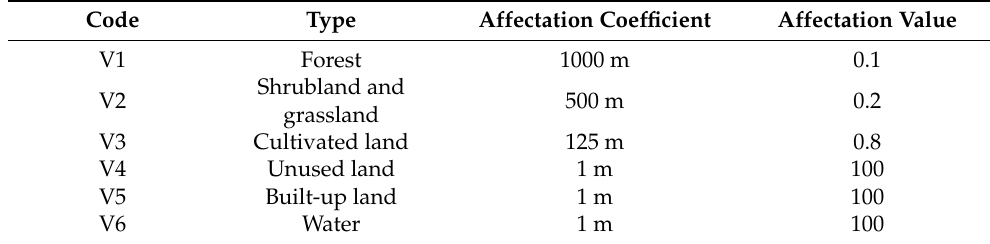
Table 5. Impact matrix (MA) for the calculation of